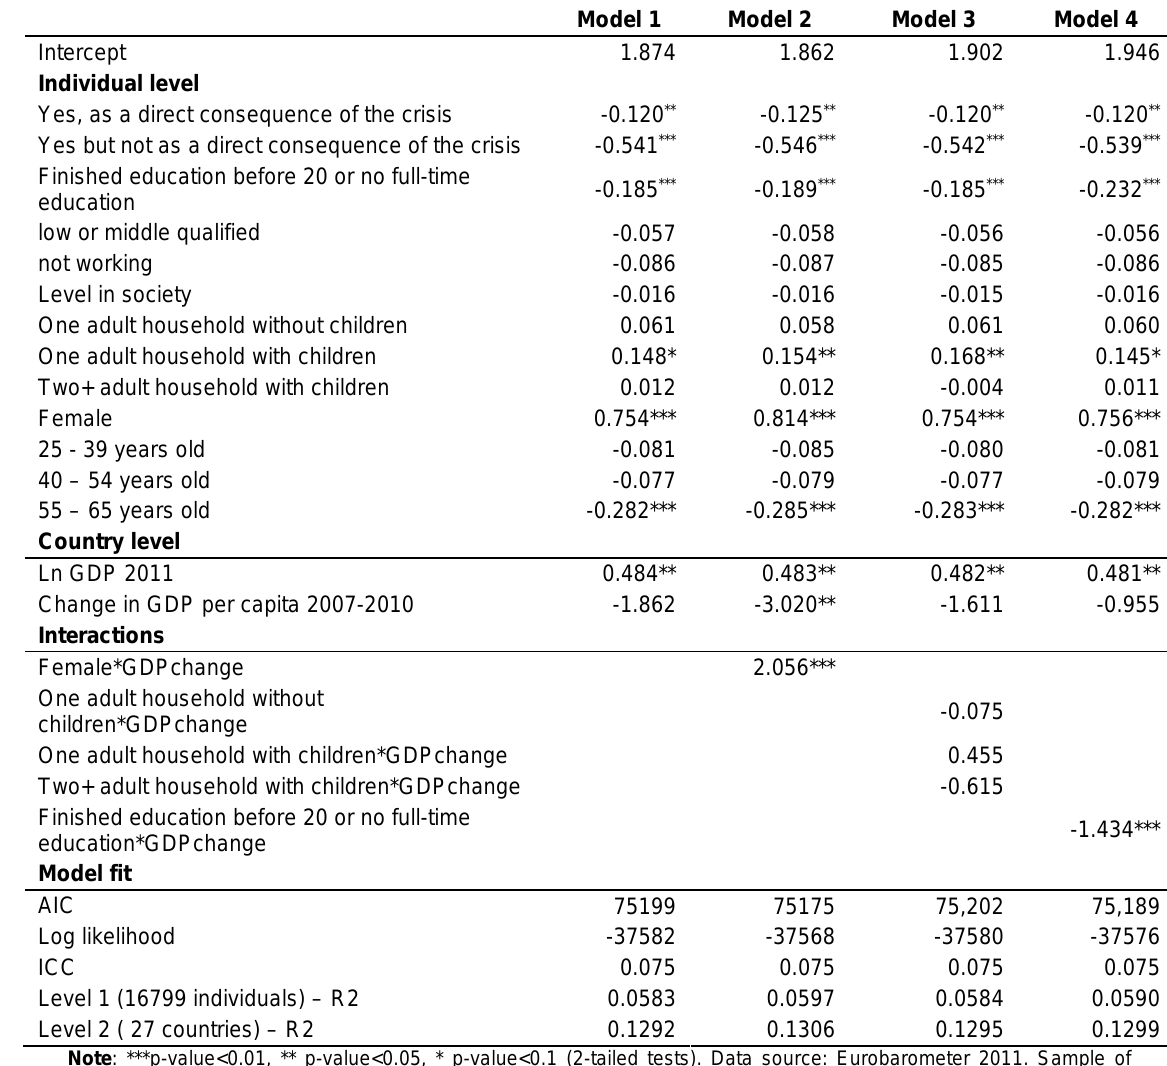
Table 1 . Multilevel regression models: dependent variable – index of gender attitudes (unstandardized regression coefficients). Macro level – GDP per capita and GDP change from 2007 to